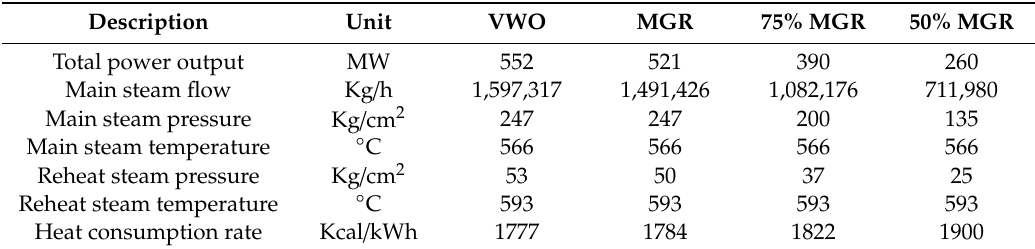
Table 2. The steam condition of 500 MW supercritical pressure coal-fired power plant .